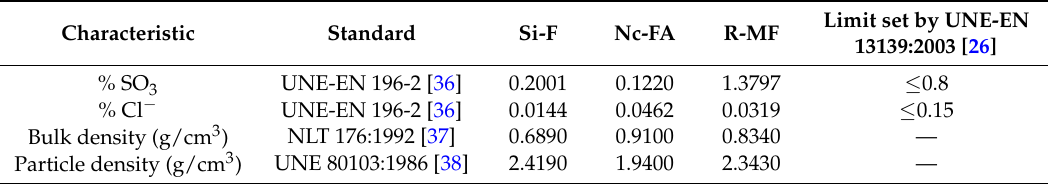
Table 4. Characterization of Si-F, Nc-FA and R-MF.